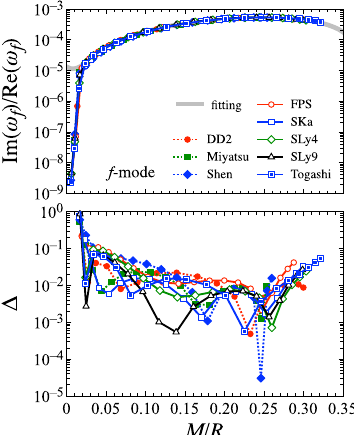
Fig. 2 In the top panel, the ratio of Im( ω ) to Re( ω ) for the f -mode is shown as a function of the stellar compactness for various neutron star models,wherethesolidlinedenotesthefittingformulagivenbyEq.(2). In the bottom pane, the relative deviation of the value of Im( ω )/Re( ω ) estimated with the empirical formula from that calculated via the eigen- value problem is shown